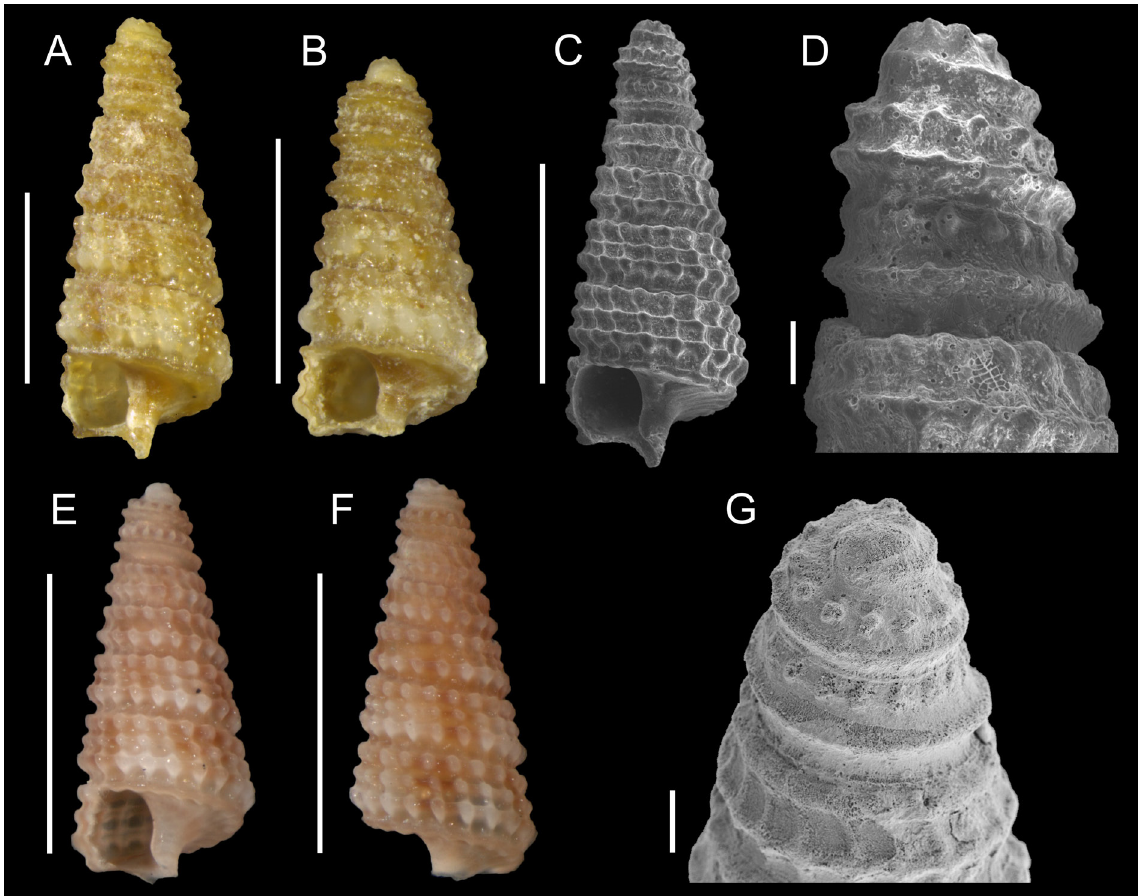
Fig. 6. Isotriphora sp. 1. A–B . MORG 52611*, 2.08 mm and 1.58 mm, respectively. C–D . Same shell as A. E–F . ZUEC-GAS 7489, 1.44 mm. G . ZUEC-GAS 7489, same shell as E. Scale bars: A–C, E–F = 1 mm; D, G = 100 µm. Photo credits E–G: Aramys Cesar